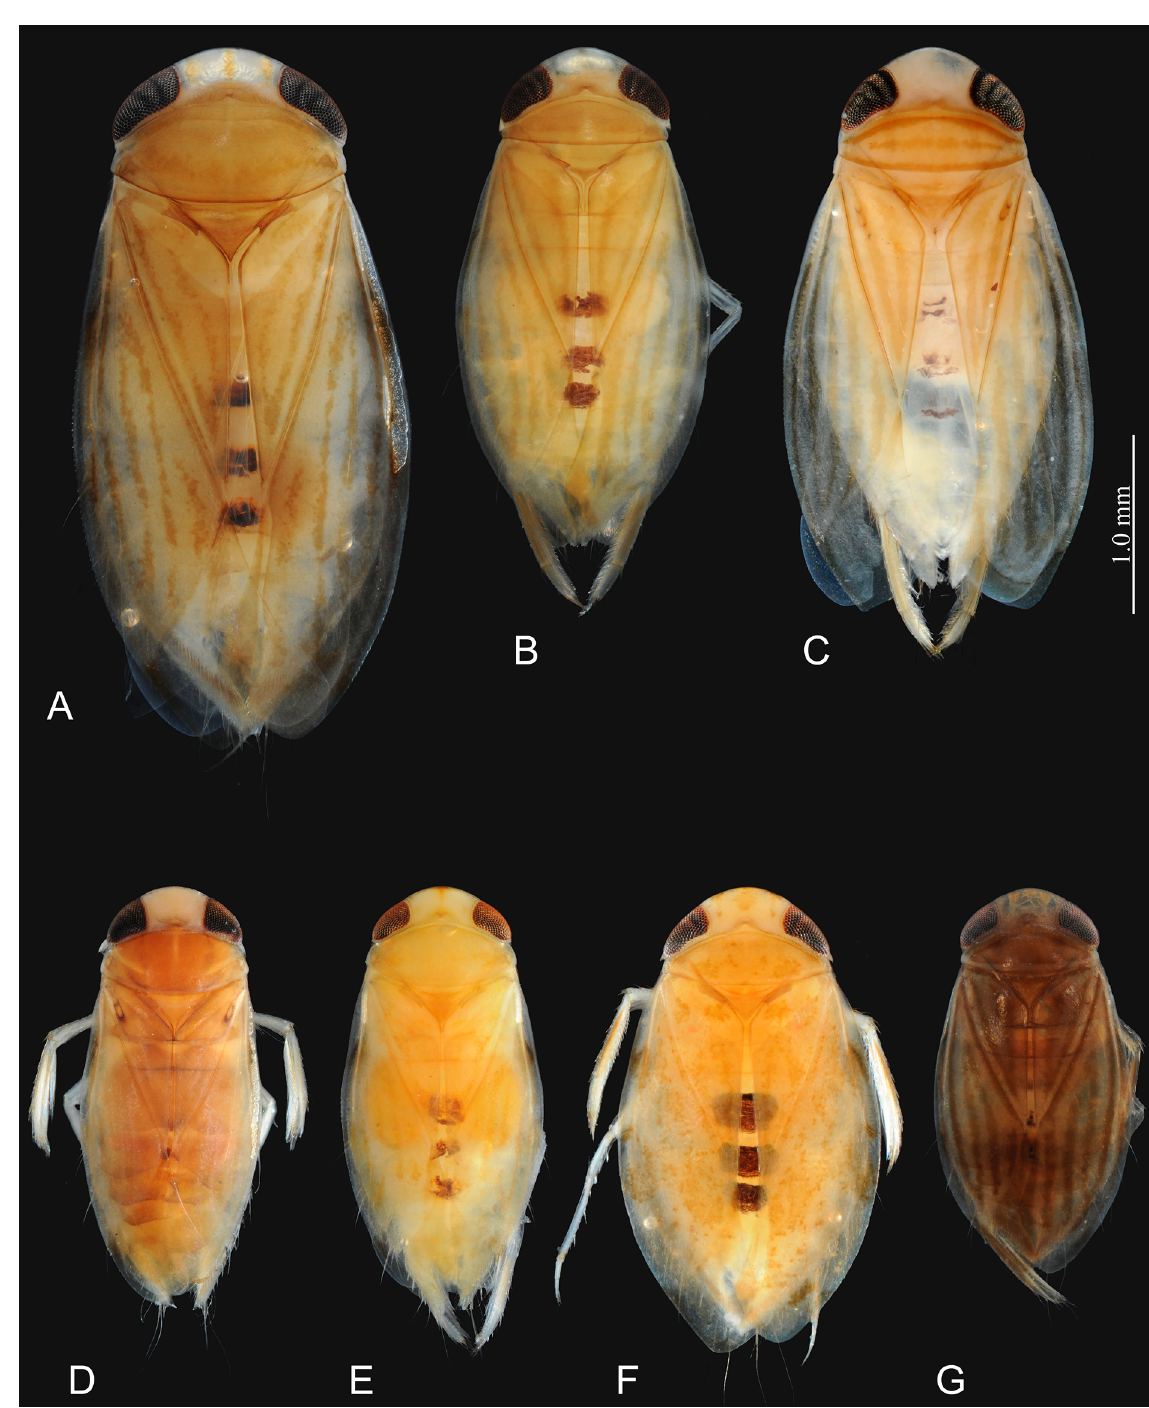
Fig. 1. Habitus photos of species of Micronecta Kirkaldy, 1897. A . M . scutellaris (Stål, 1858), ♂ (ZVNU). B . M . sedula Horváth, 1905, ♂ (ZVNU). C . M . siva (Kirkaldy, 1897), ♀ (ZVNU). D . M. jaczewskii Wróblewski, 1962, ♂ (ZVNU). E . M . decorata Lundblad, 1933, ♂ (ZRC). F . M. desertana Distant, 1920, ♂ (ZVNU). G . M . ludibunda Breddin, 1905, ♂ (ZVNU). All to the same